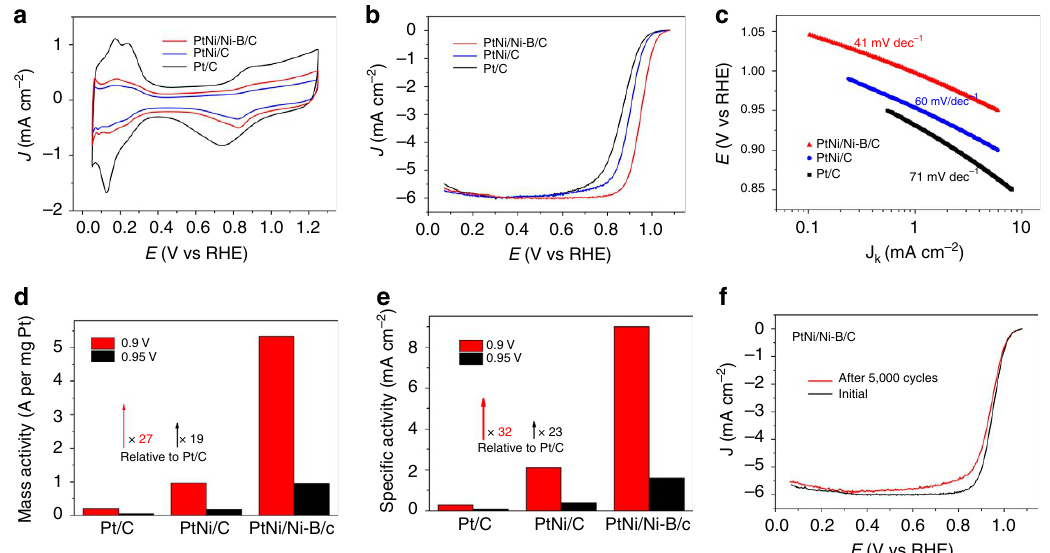
Figure 3 | Electrochemical properties of PtNi/Ni–B. ( a ) Cyclic voltammetry curves of PtNi/Ni–B/C, PtNi/C and Pt/C catalyst in N 2 -saturated 0.1M HClO 4 solution with a sweep rate of 50mVs (cid:2) 1 . ( b ) ORR polarization curves. ( c ) The corresponding Tafel plots for PtNi/Ni–B/C, PtNi/C and Pt/C in O 2 -saturated 0.1M HClO 4 solution with a sweep rate of 10mVs (cid:2) 1 and a rotation rate of 1,600r.p.m. The currents were normalized to the geometric area of the rotating disk electrode (0.196cm 2 ). ( d ) Mass activity for these three catalysts at 0.9 and 0.95V versus RHE. For the PtNi/C or PtNi/Ni–B/C catalyst, the Pt loading on a RDE was 1.2 m g, whereas the Pt loading was 2.4 m g for the Pt/C catalyst. ( e ) Comparison of specific activity at 0.9 and 0.95V based on the ECSAs calculated from the charges associated with H upd . ( f ) ORR polarization curves of PtNi/Ni–B/C before and after 5,000 cycles between 0.6 and